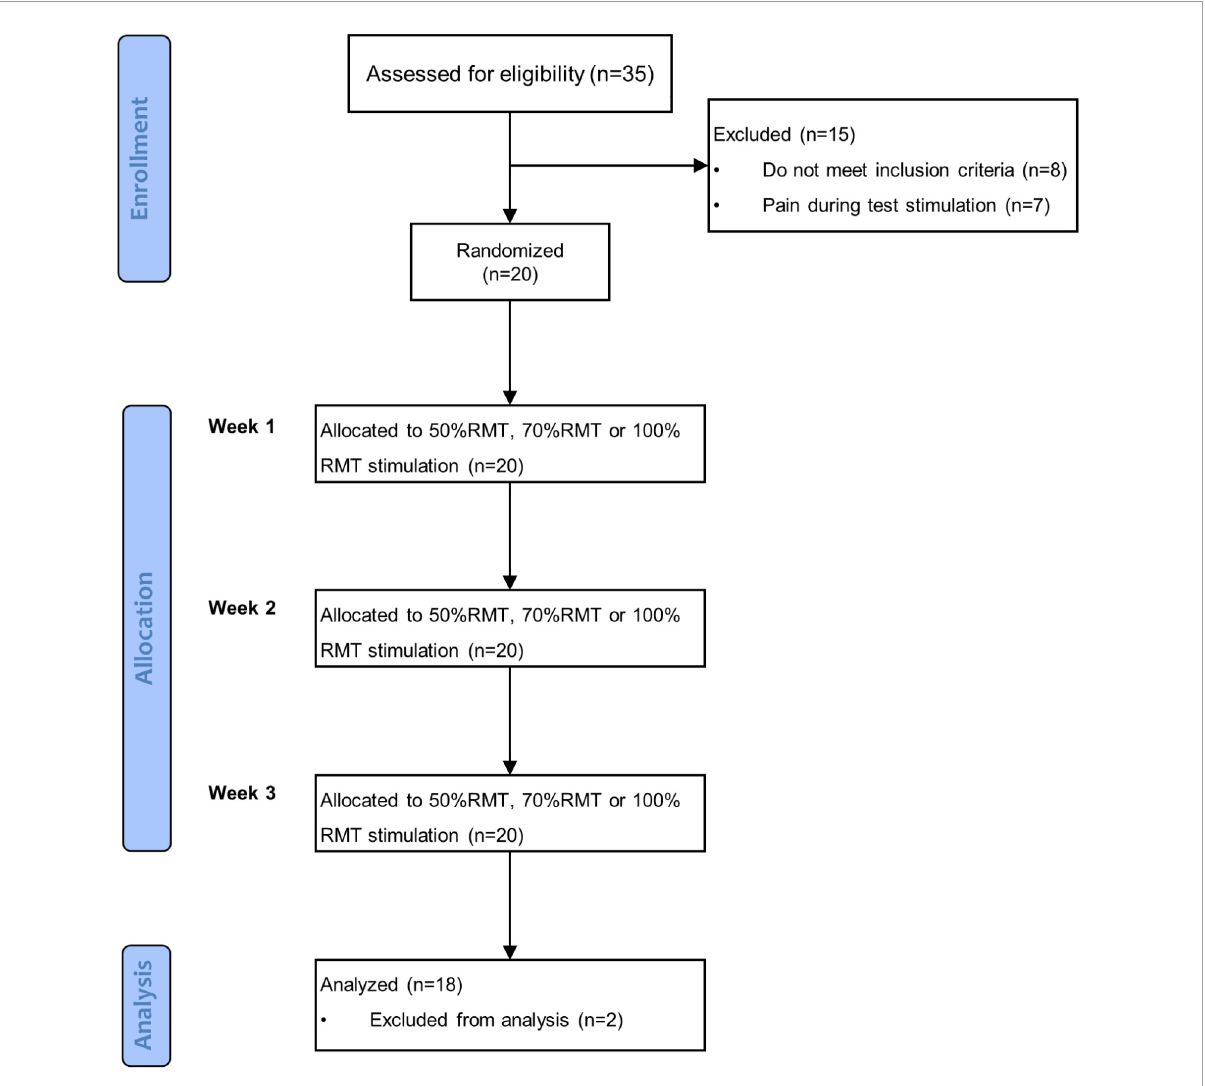
FIGURE1 Flowchart of the experiment